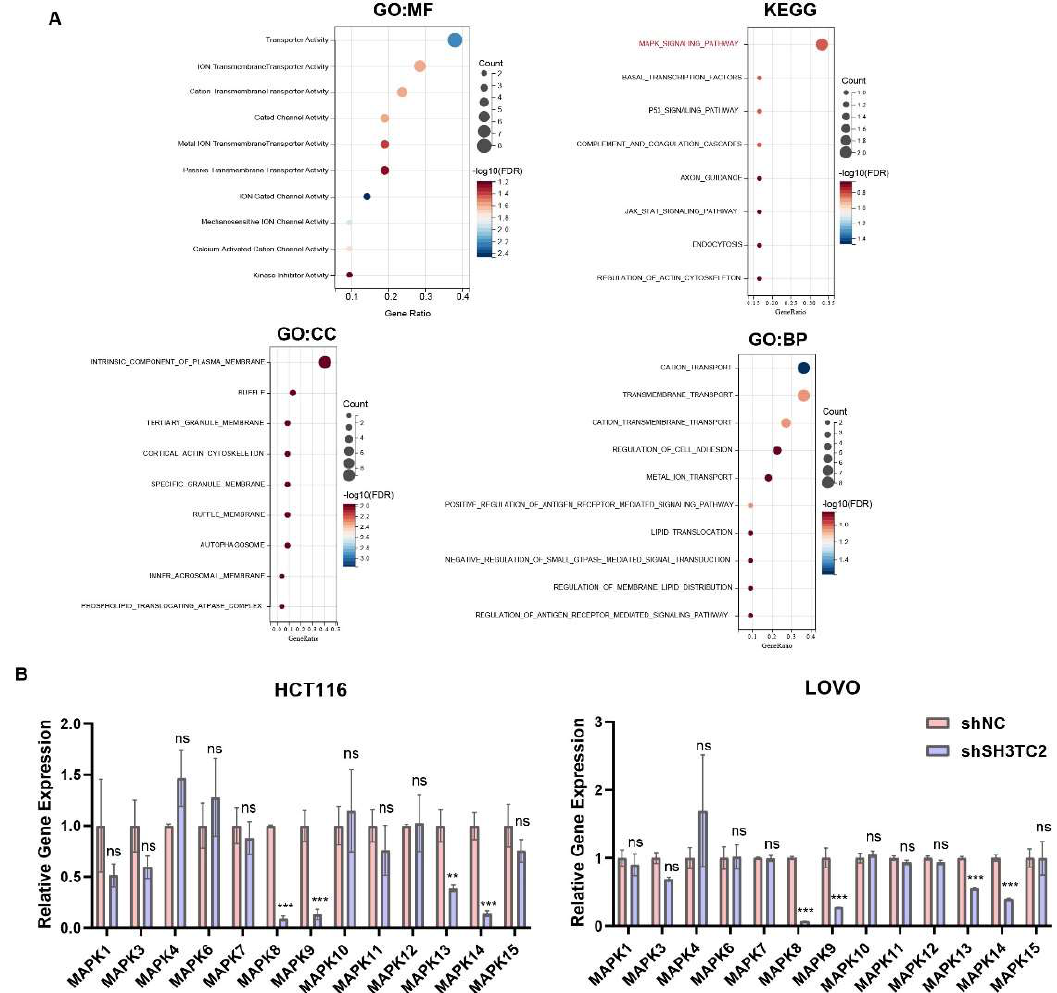
Figure 5. Genes co-expressed with SH3TC2 and functional enrichment analysis. ( A ) GO and KEGG functional enrichment analyses were performed on SH3TC2 and co−expressed genes in CRC. Bioin- formatics analysis implied that the MAPK pathway was most likely correlated with the expression of SH3TC2. ( B ) The qRT−PCR analysis of key points of MAPK pathway regulators after the stable transfection of shSH3TC2 in HCT116 and LOVO cells. The results implied that MAPK8, MAPK9, MAPK13, and MAPK14 were significantly regulated after silencing SH3TC2. Statistical analysis was compared to the control group: ns, not significant; ** p < 0.01; *** p < 0.001.